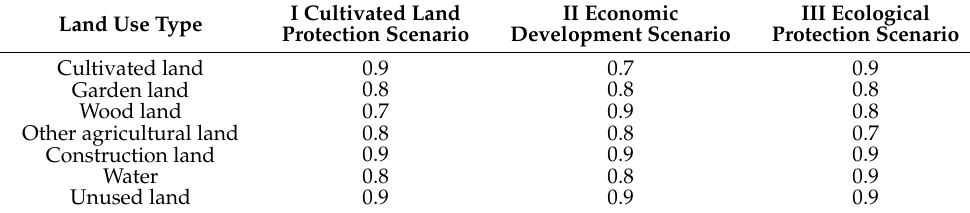
Table 4. The ELAS of land use landscape types under different scenarios.